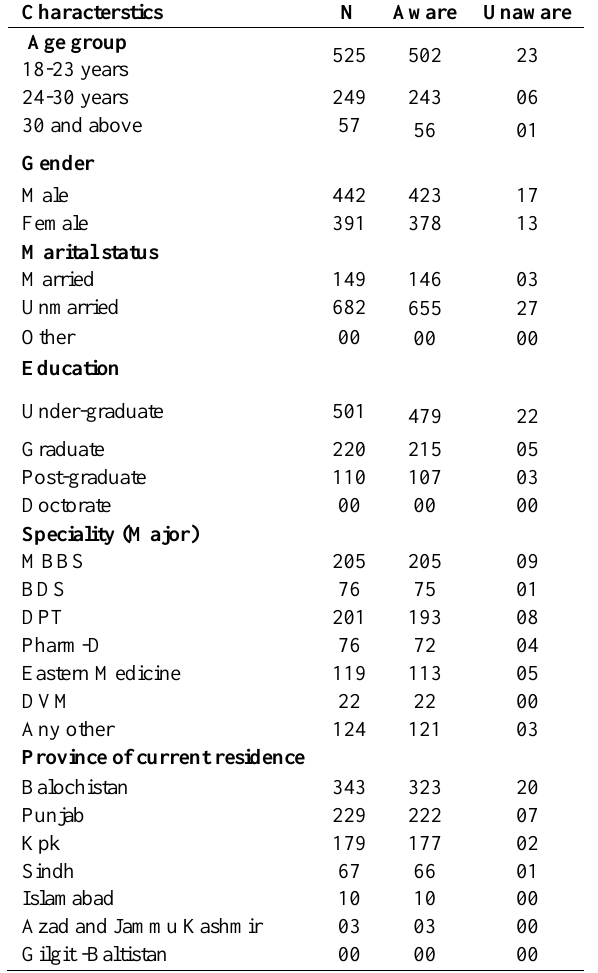
Table 4: Cross tabulation between the demographics and